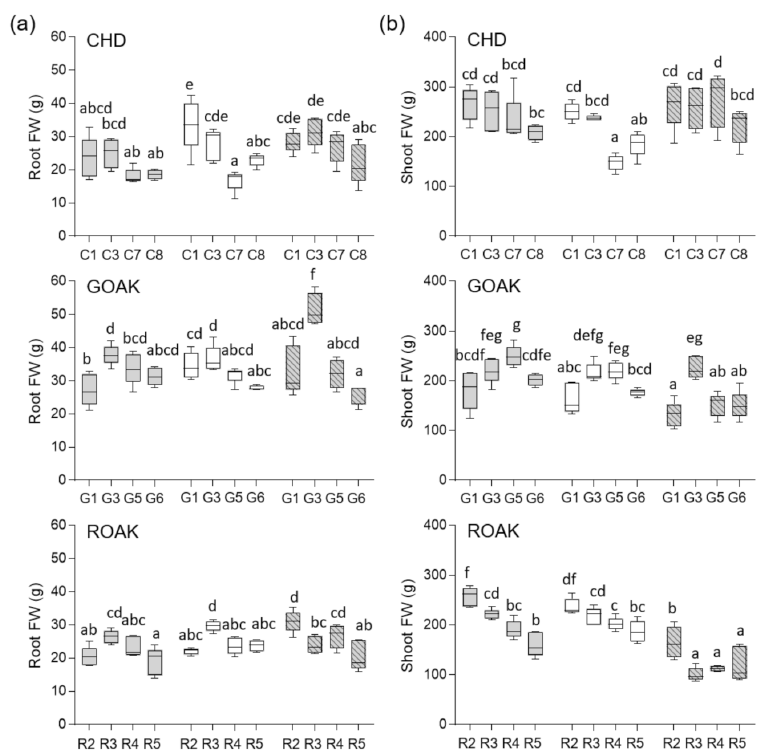
Figure 5. Fresh weight of the studied genotypes at the end of the experiment. ( a ) Root FW and ( b ) shoot FW (Fall, grey-filled bars; Winter, white-filled bars; Spring, lined-filled bars). Different letters indicate significant ( p -value < 0.01) differences between CHD, GOAK and ROAK samples. Despite their small root systems, shoot weights were significantly ( p -value =